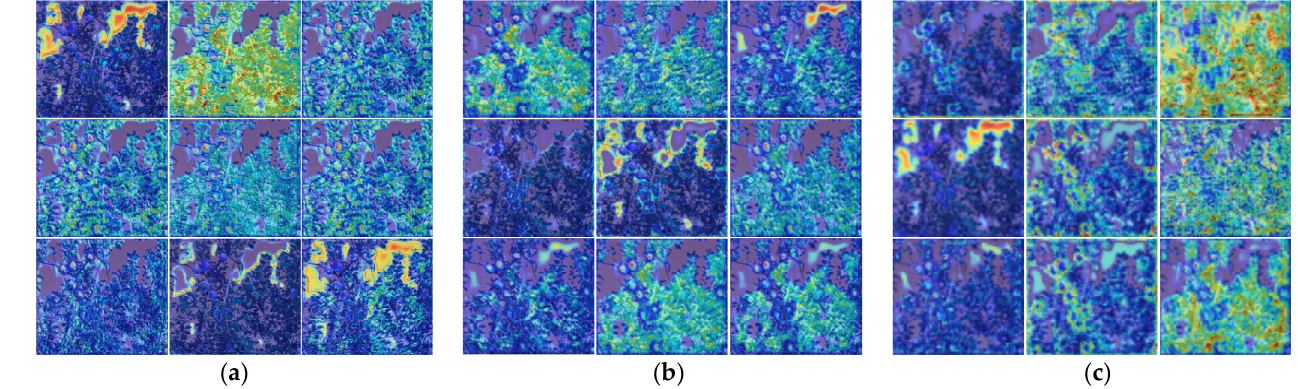
Figure 8. Neck network feature map. ( a ). C3ghost output 80 × 80 characteristic figure. ( b ). C3ghost output 40 × 40 characteristic figure. ( c ). C3ghost output 20 × 20 characteristic figure.